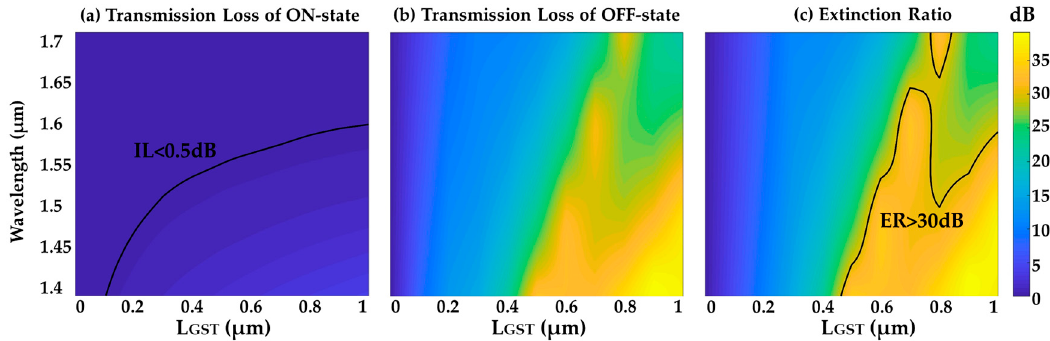
Figure 7. ( a ) Transmission loss of ON-state (amorphous phase). ( b ) Transmission loss of OFF-state (crystalline phase). ( c ) ON-OFF switching extinction ratio when GST phase change occurs.